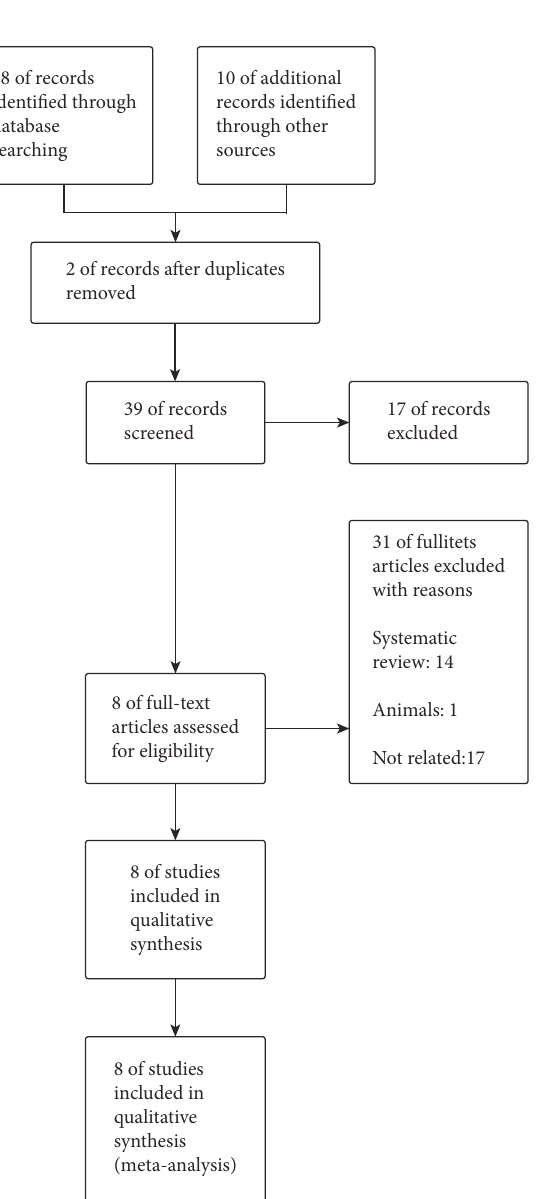
Figure 1: Flowchart for article